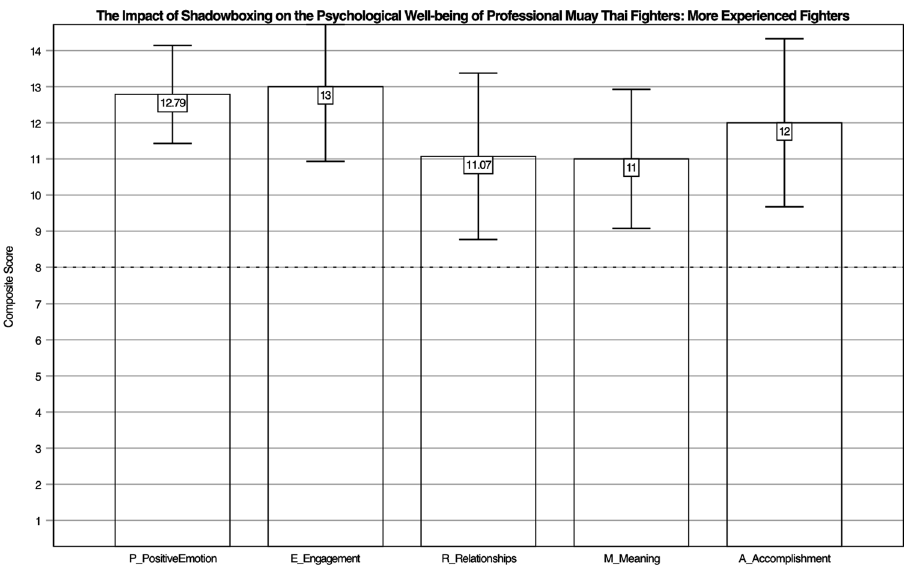
Fig. 4 This figure provides a bar plot with 95% confidence intervals (CIs) for composite PERMA scores: more experienced Nak Muays (n = 7). For each element of psychological well-being, the lowest possible composite score is 2 representing that professional Nak Muays strongly agree that shadowboxing negatively impacts that element of psychological well-being, whereas the highest possible composite score is 14 representing that professional Nak Muays strongly agree that shadowboxing positively impacts that element of psychological well-being. A composite score of 8 (dotted line) reflects a neutral position on whether shadowboxing contributes positively or negatively to that element. Results in this figure show that more experienced Nak Muays strongly agree that shadowboxing positively contributes to all elements of their psychological well-being. Further, results in this figure show that shadowboxing contributes to the elements of psychological well- being in the following rank-order for more experienced Nak Muays: engagement (E), positive emotions (P), accomplishment (A), relation- ships (R), and meaning (M)